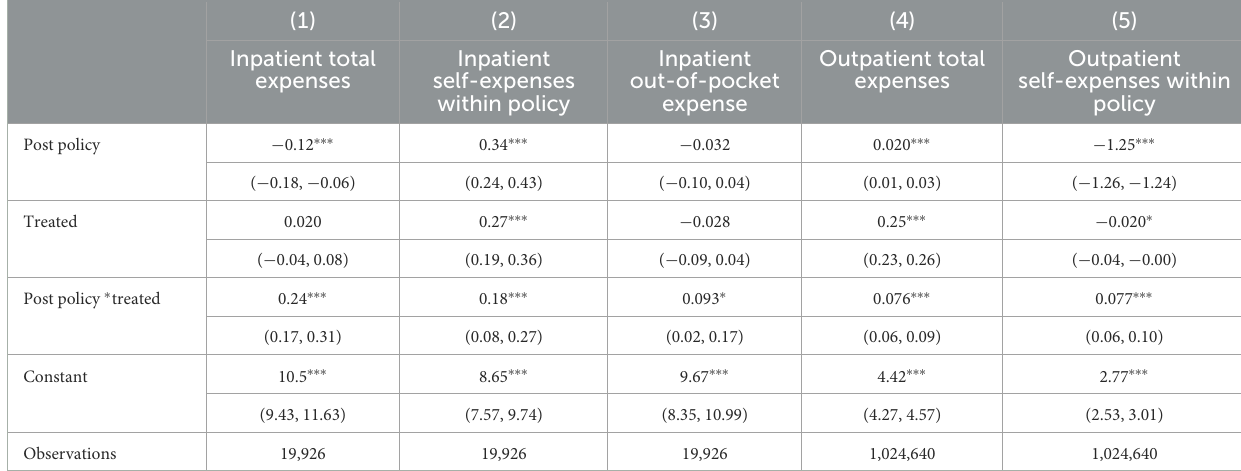
TABLE 8 DID regression analysis of the effect of policy change on medical expenses per